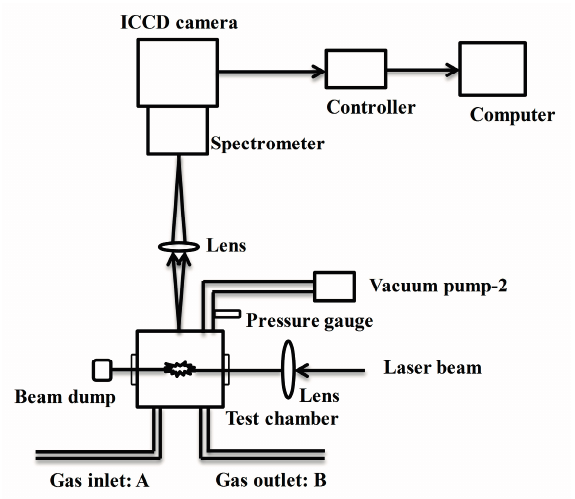
Figure 3. Schematic diagram of the laser-induced breakdown spectroscopy (LIBS) system.